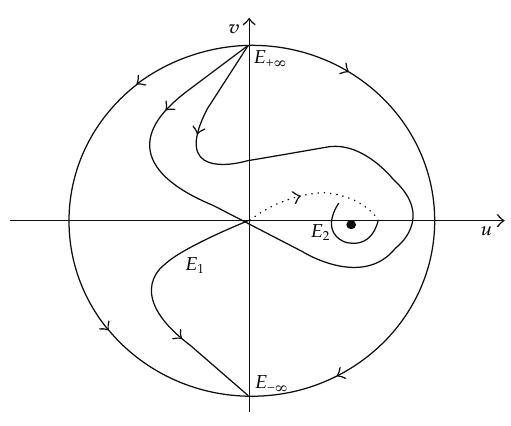
Figure 4: Global phase portrait of (cid:5) 2.3 (cid:6) for e > 0, g < 0, and g 2 − 4 e <